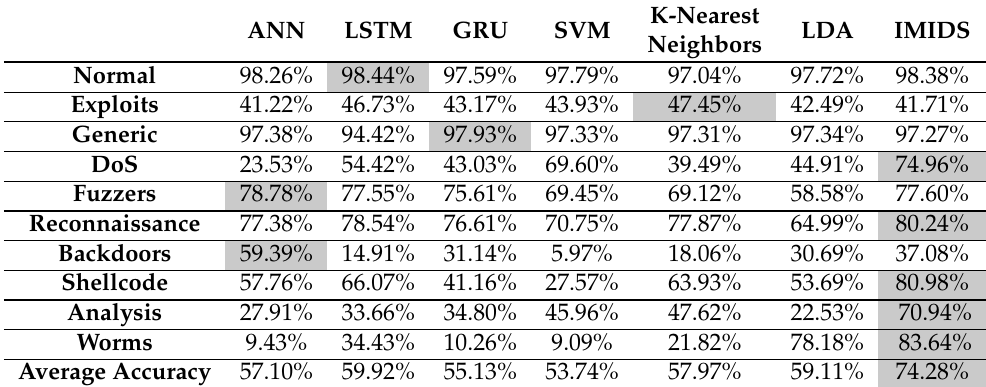
Table 2. Comparing the attack classification accuracy between IMIDS and recent models for IDSs.